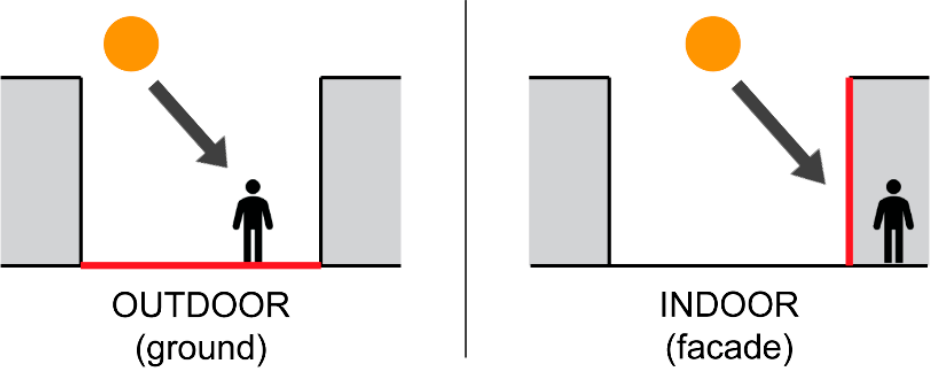
Figure 7. Two types of analysis surfaces (ground—left, façade—right) used to assess the outdoor and indoor environment.